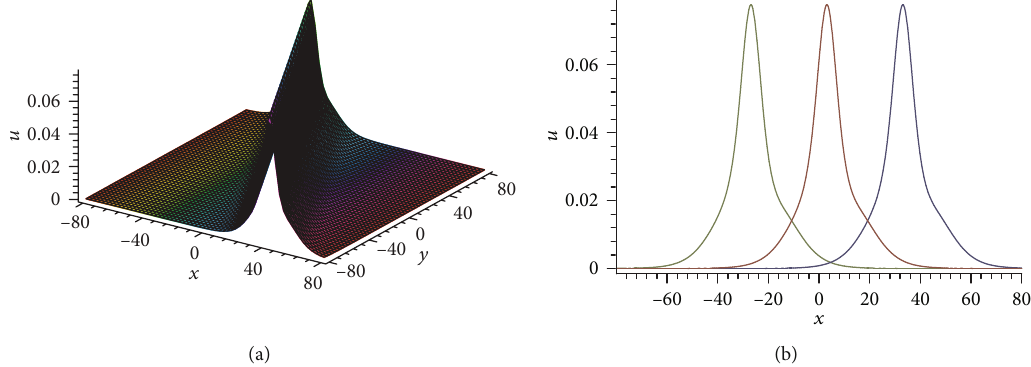
Figure 2: (a) Asymmetric soliton of the ð 2 + 1 Þ -dimensional higher-order Boussinesq equation. (b) The wave propagation pattern along the x -axis by selecting di ff erent times t = 60 , t = 0 , and t = − 60 (from left to